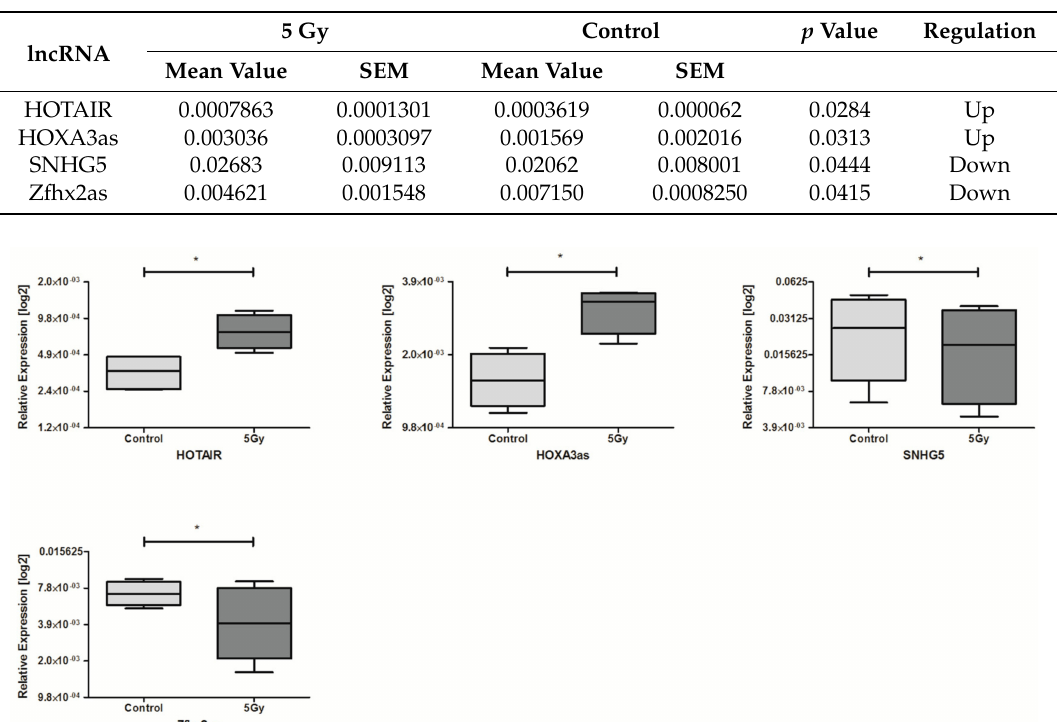
Table 2. Expression values of HOTAIR, HOXA3as, SNHG5, and Zfhx2as after exposure to 5 Gy irradiation.